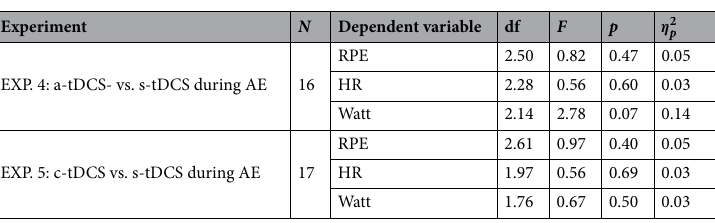
Table 2. Statistical values of the exercise-related dependent variables. Only the values for the Time × Condition interactions are shown.